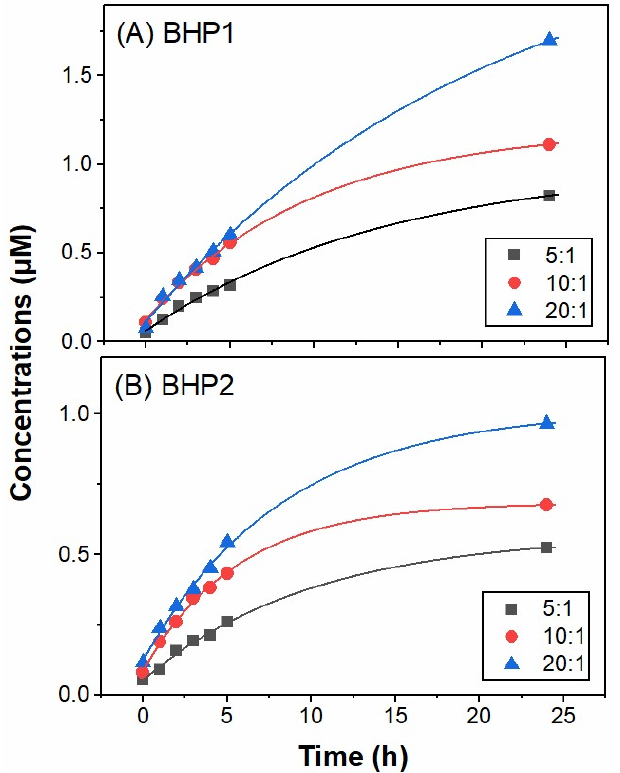
Figure 2. Time-dependent formation of ( A ) BHP1 and ( B ) BHP2 at different H 2 O 2 :BR molar ratios (5:1, 10:1, and 20:1). The reactions were carried in phosphate buffer (100 mM, pH 7.4) with an initial BR concentration of 200 μ M and initial H 2 O 2 concentration at 1.0, 2.0, and 4.0 mM.